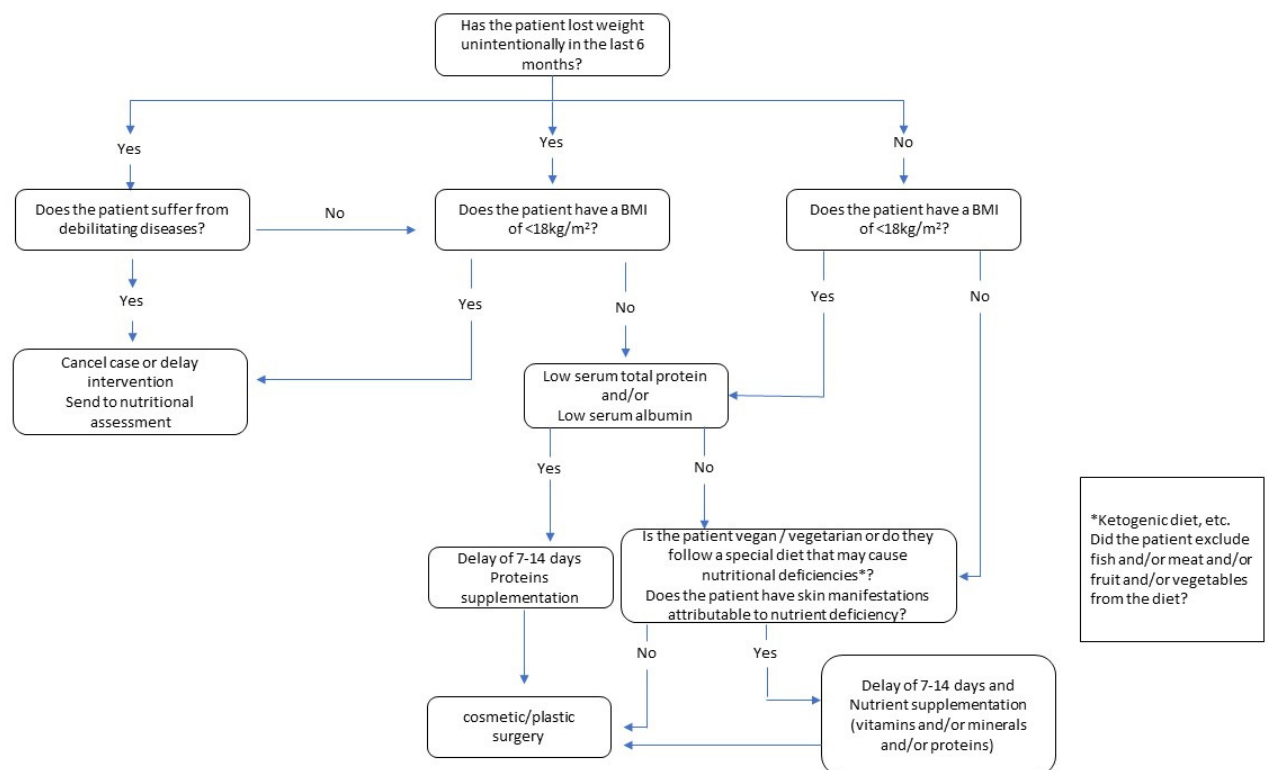
Figure 1. Decision flowchart for cosmetic surgery and aesthetic